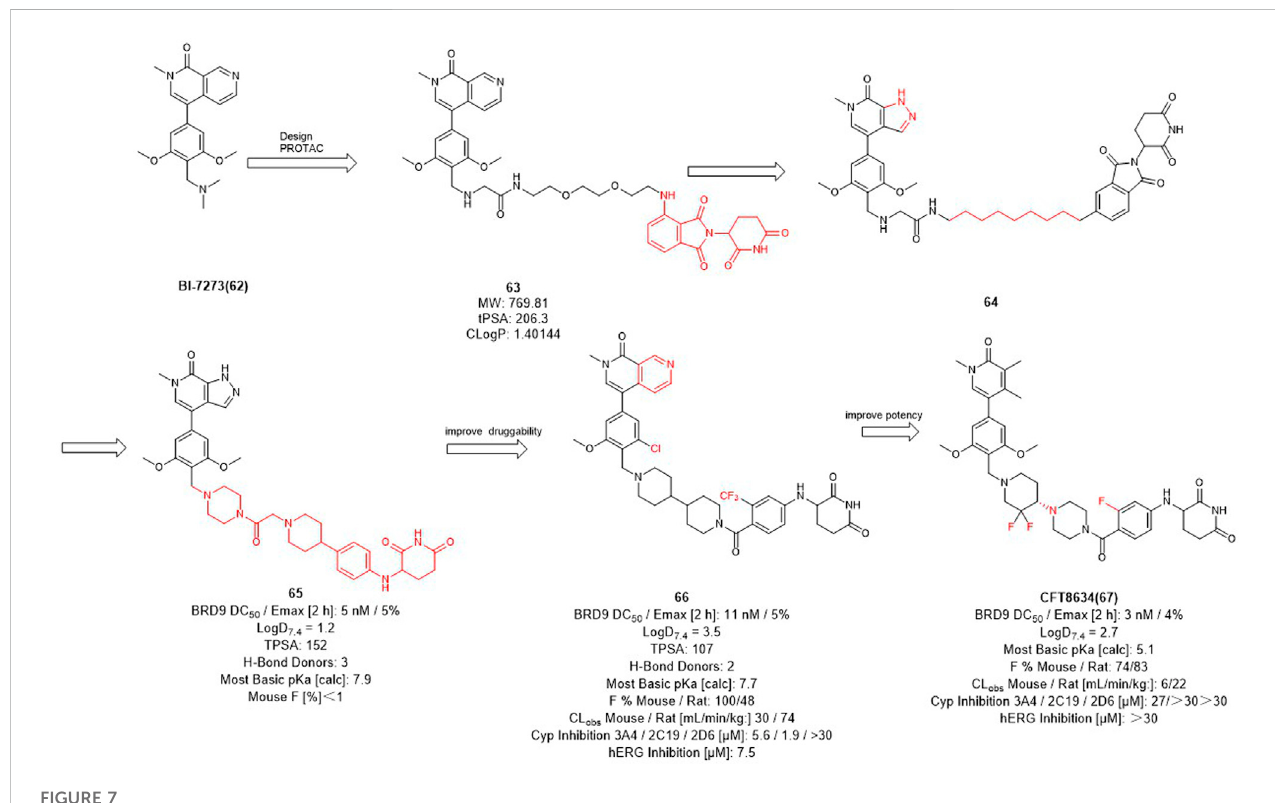
FIGURE 7 Design and optimization of BRD9 PROTACs.